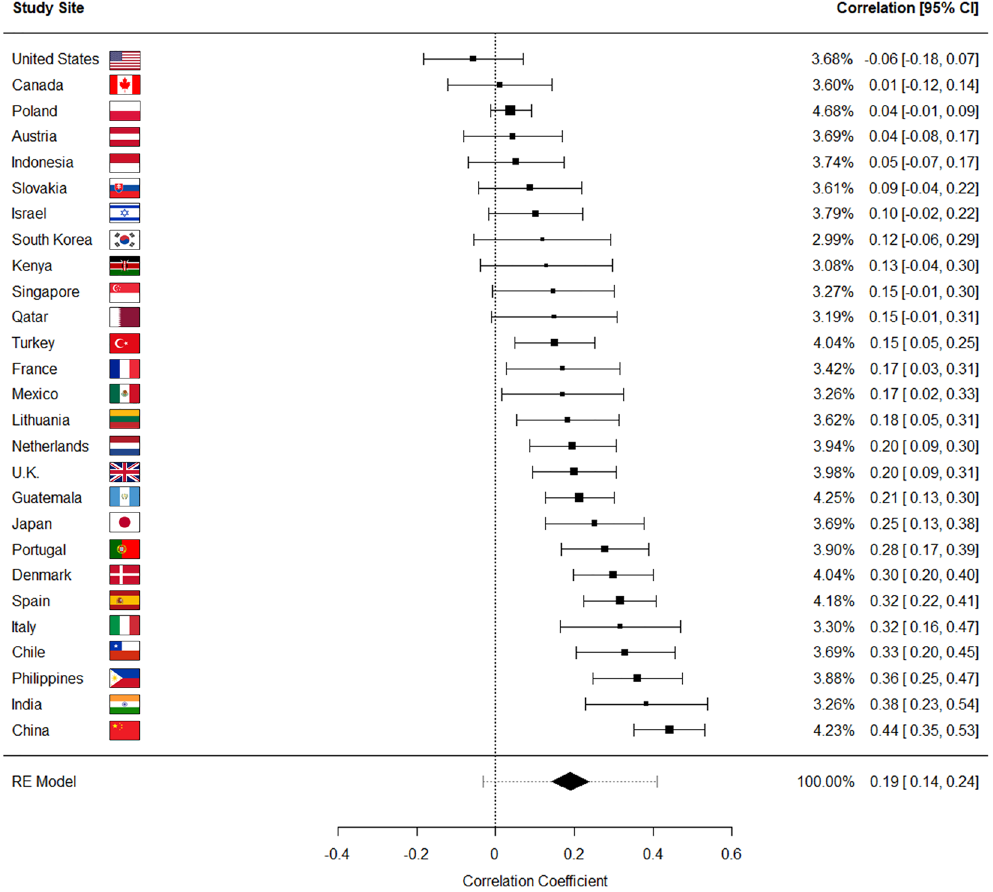
Figure 1. Results of a random effects, restricted maximum likelihood meta-analysis in which each study site was treated as a separate sample. Plot shows zero-order product-moment correlations between traditionalism and COVID-19 health precautions at each study site, ordered by effect size. For the individual country estimates, the location of the square along the x-axis corresponds with the correlation coefficient, the size of the square corresponds with the weight of that study site in the meta-analysis, and bands are 95% confidence intervals. At the bottom of the plot, an overall meta-analyzed point estimate is provided. The midpoint of the diamond corresponds with that point estimate, the width of the diamond corresponds with the 95% CI, and the dotted bands correspond with the 95% prediction interval. On the right side of the plot, weights, correlation coefficients, and 95% CIs respectively are numerically listed for both the site-specific correlations, as well as the overall estimate. Note that for the overall meta-analyzed point estimate, the 95% confidence interval does not overlap with zero, while the 95% prediction interval